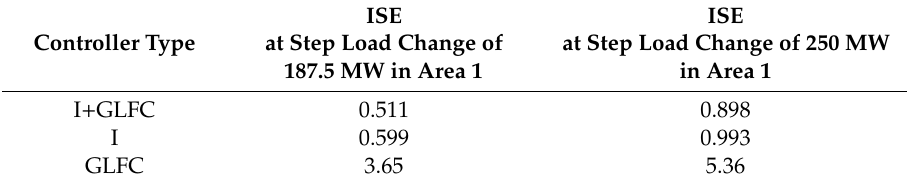
Table 5. The Performance index of ∆ P tie 12